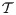
The transformation T in the proof of Theorem 22.